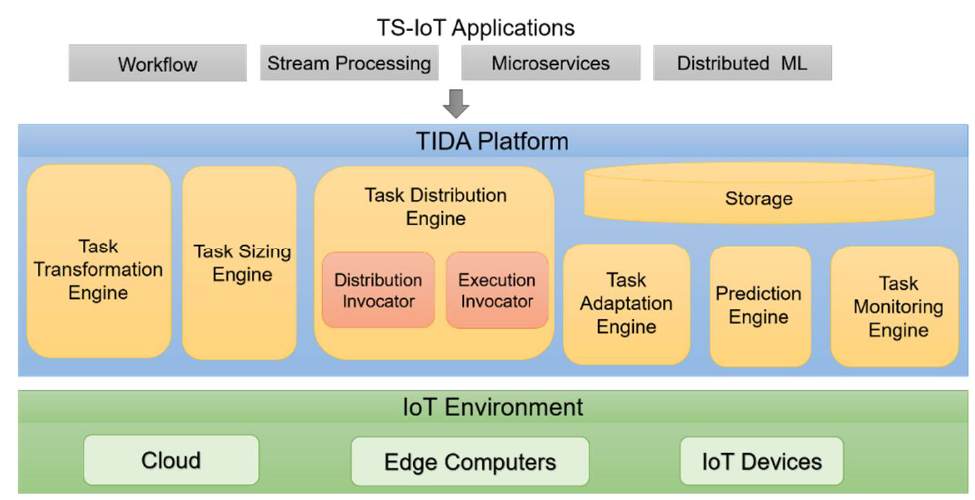
Figure 4. The architecture of the TIDA platform.